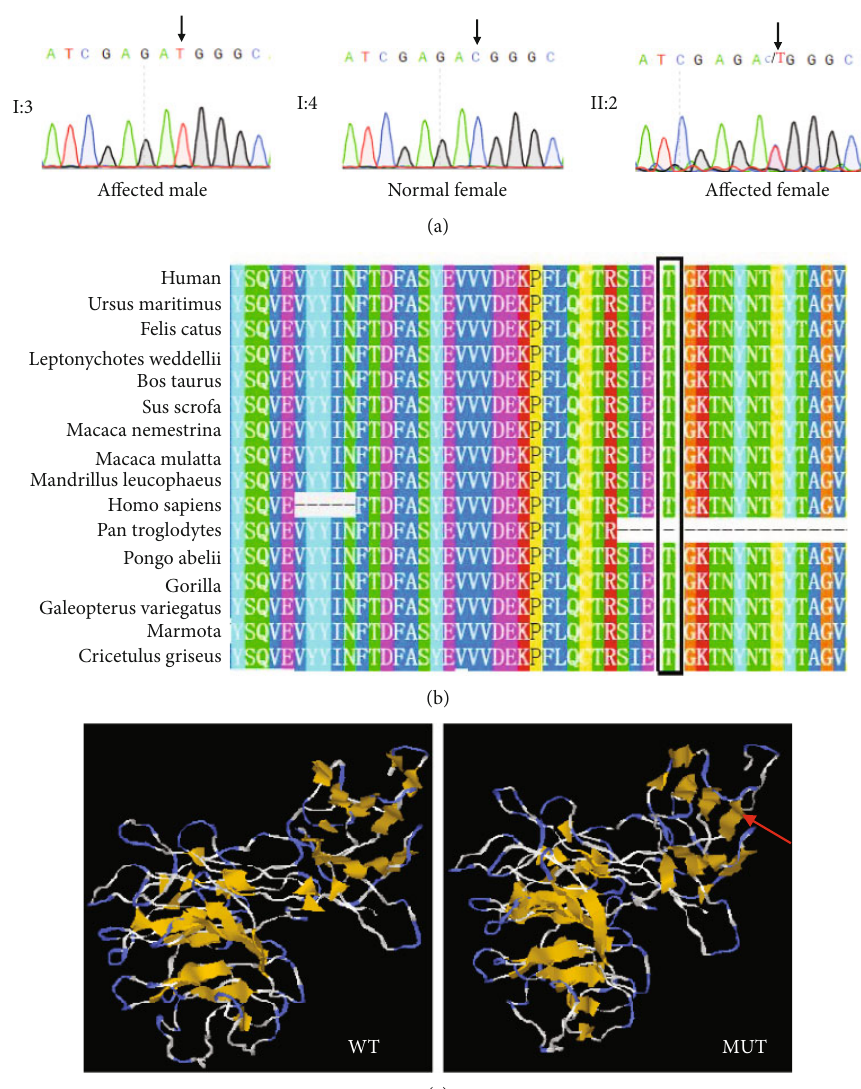
Figure 3: Mutation analysis. (a) Mutation screening. Sanger sequencing results of wild-type and mutant EDA. (b) Conservation of the mutant EDA across species. (c) Three-dimensional models of wild-type and mutant